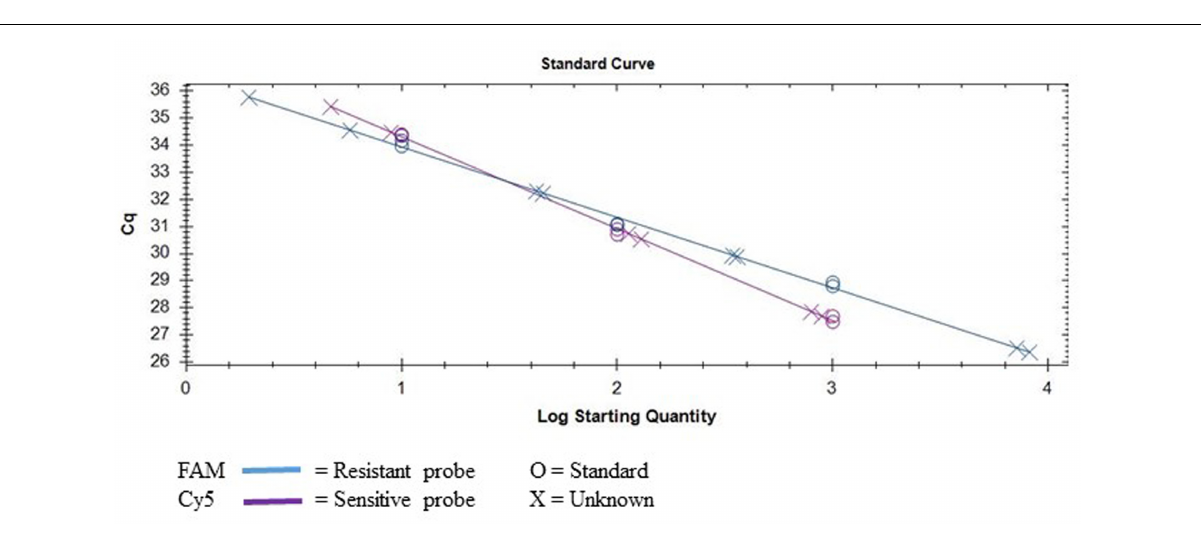
( Table 4 ). The y-axis on the amplification plot measures the relative fluorescence units (RFU), a measure of the amplified DNA, while cycling threshold value (cq) on the x-axis, is inversely proportional to the initial concentration of nucleic acid template in each sample, which correlates to the number of copies in each